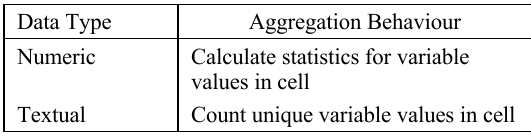
Table 2 . Geo-binning behaviour for data